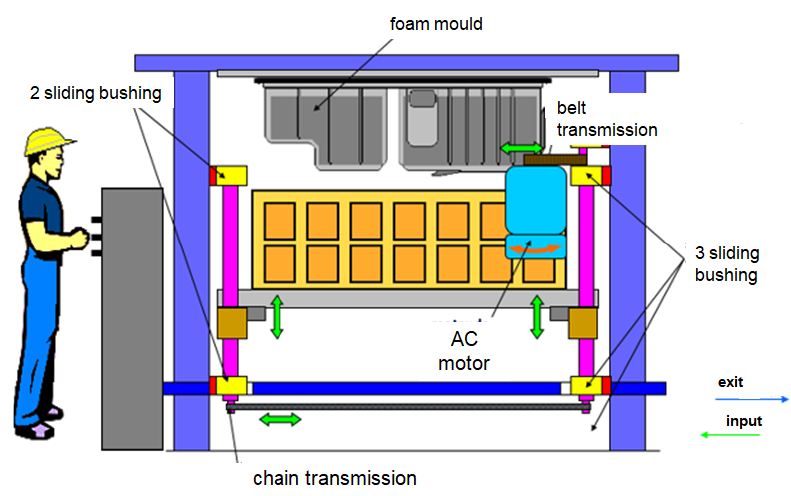
Figure 7. The operation mode of the conformer.